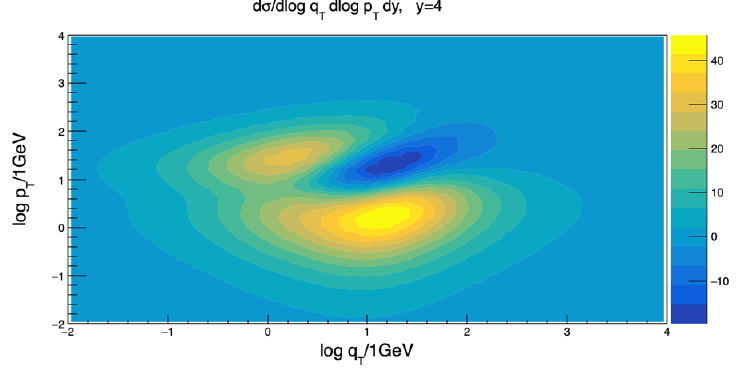
Figure 8 . Partonic cross section with the correlated Pomeron loop, eq. (3.4) as a function of the momentum transfer q T and the transverse momentum of the produced vector meson p T . Evolution variable in the BFKL equation is (cid:22) (cid:11) s y = 0 :